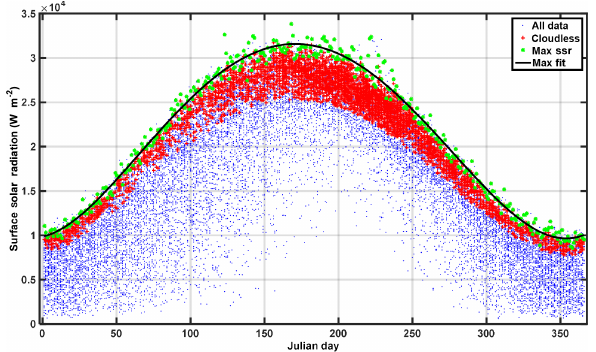
Figure 10. Changes in yearly mean SSR to relative to the 1954– 2012 average for cloudless sky (in percent; black). AVHRR AOD series (red) and ChArMEx AOD climatology (blue; Nabat et al., 2013) for the Athens area is shown in the right